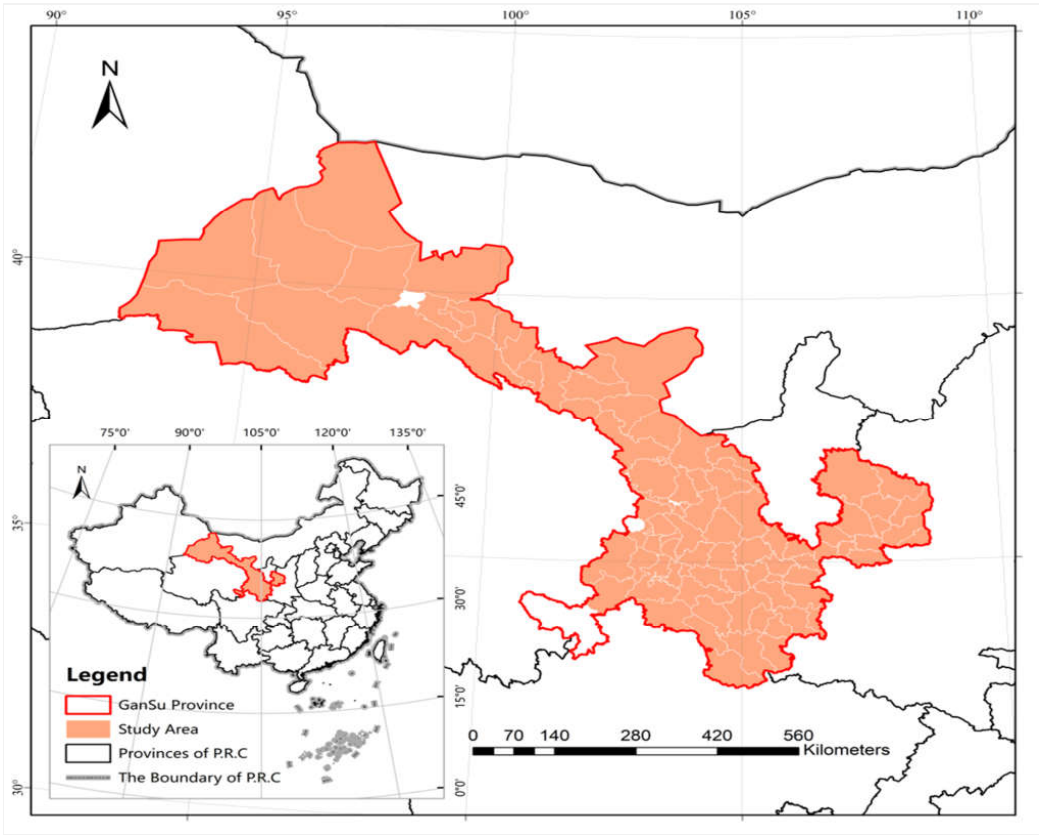
Figure 1. Study Area.